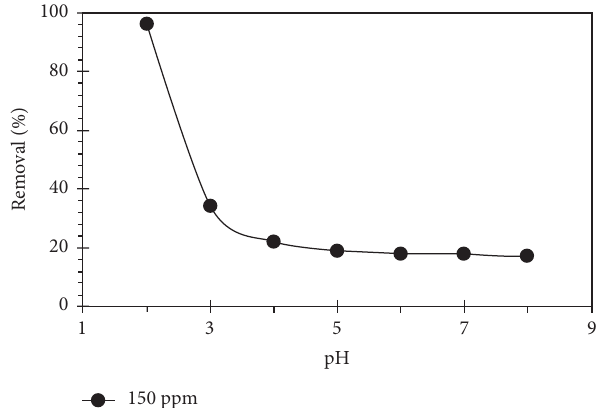
Figure 2: Effect of initial solution pH on Congo red adsorption by fish bone powder (FBP) (adsorbent: 100mg; adsorbate volume: 100mL; adsorbate concentration: 150mg · L − 1 ; contact time: